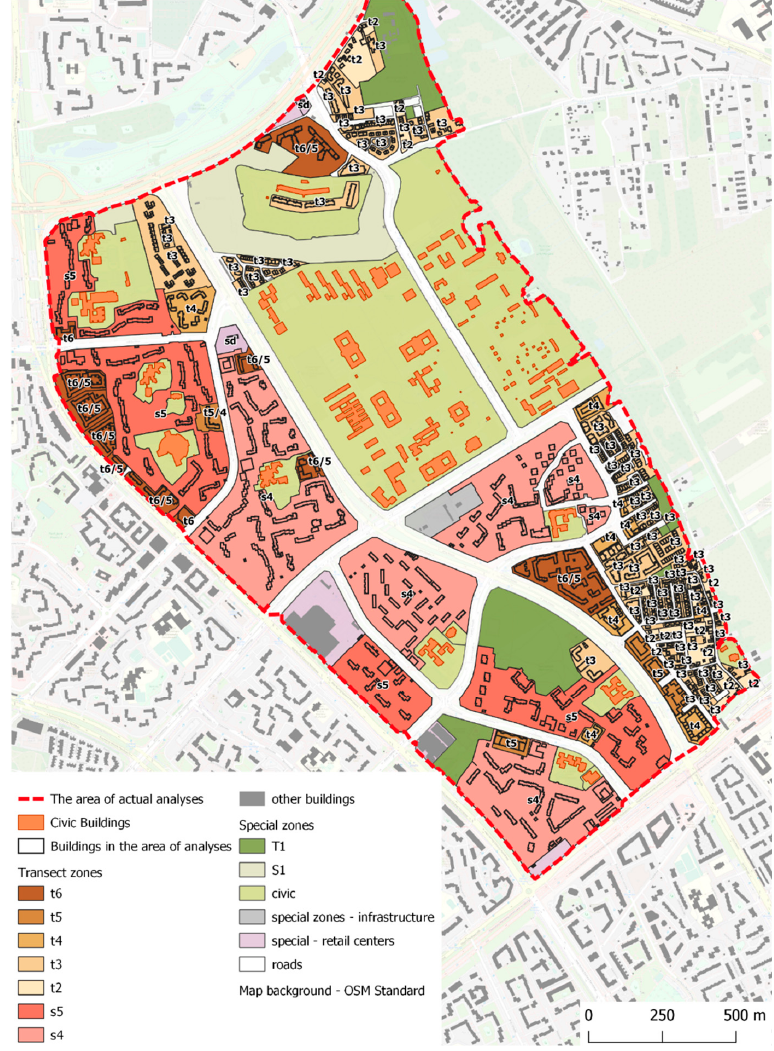
Figure 11. The urban structure of the analyzed area in transect zones. Source: own study.